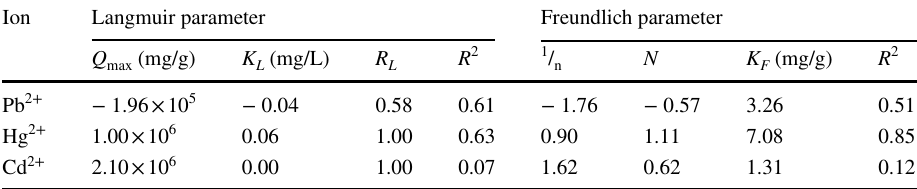
Table 3 Adsorption isotherm modelling the results of the toxic metals of the